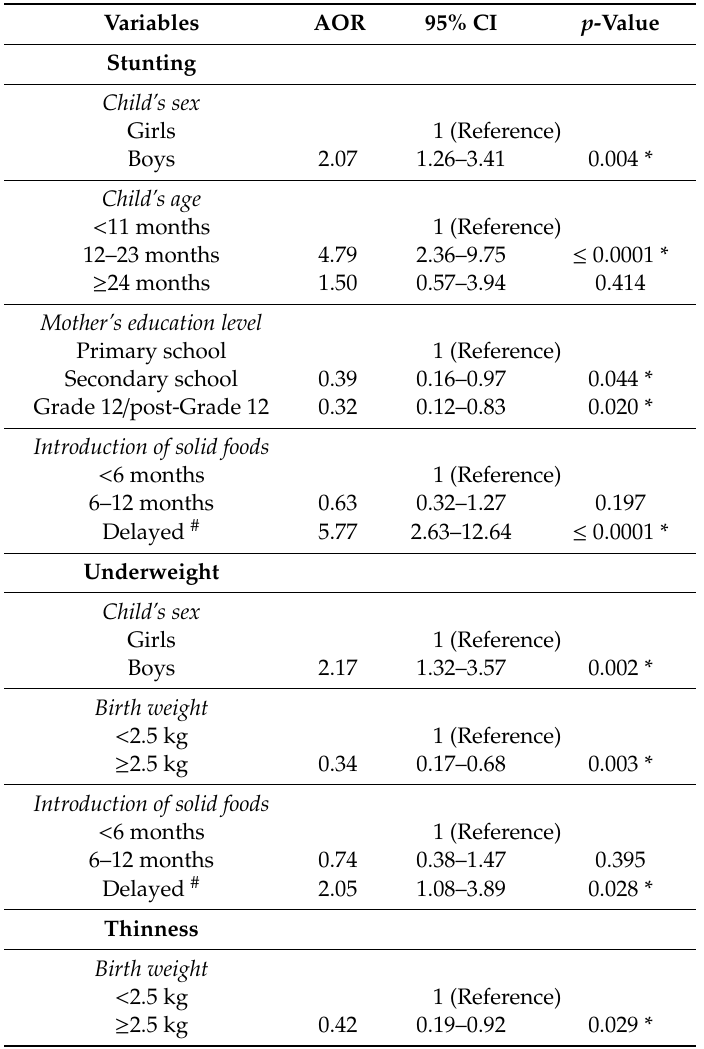
Table 5. Association of malnutrition indicators with selected independent